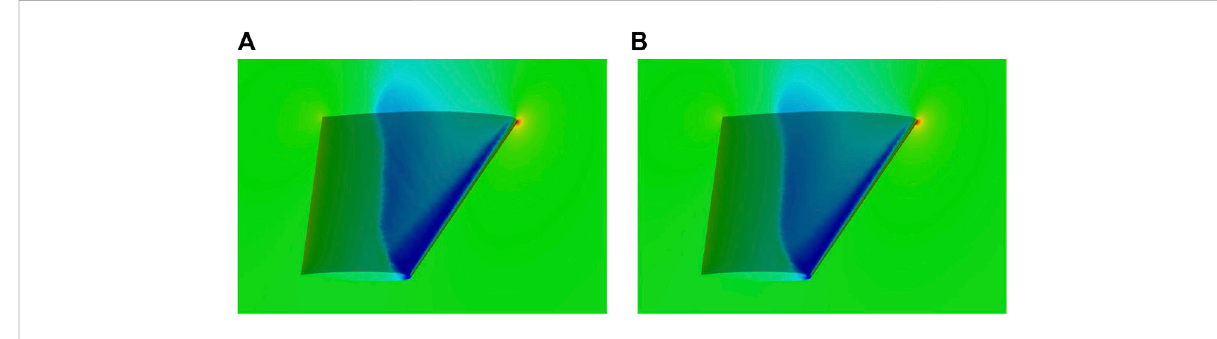
FIGURE 6 (A) ThecomputedpressuredistributiononthesurfaceofONERAM6with P 1 Q 1 element. (B) Thecomputedpressuredistributiononthesurface of ONERA M6 with P 2 Q 2 element.